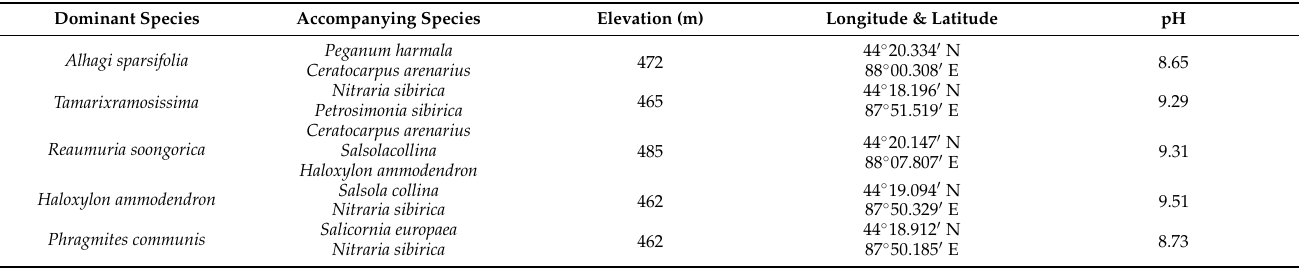
Figure 1. Location of the study area and experimental sites ( Haloxlon ammodendron , Phragmites communis , Tamarix ramosissima , Alhagi sparsifolia , and Reamuria soongorica communities). Table 1. Characteristics of the five plant communities.